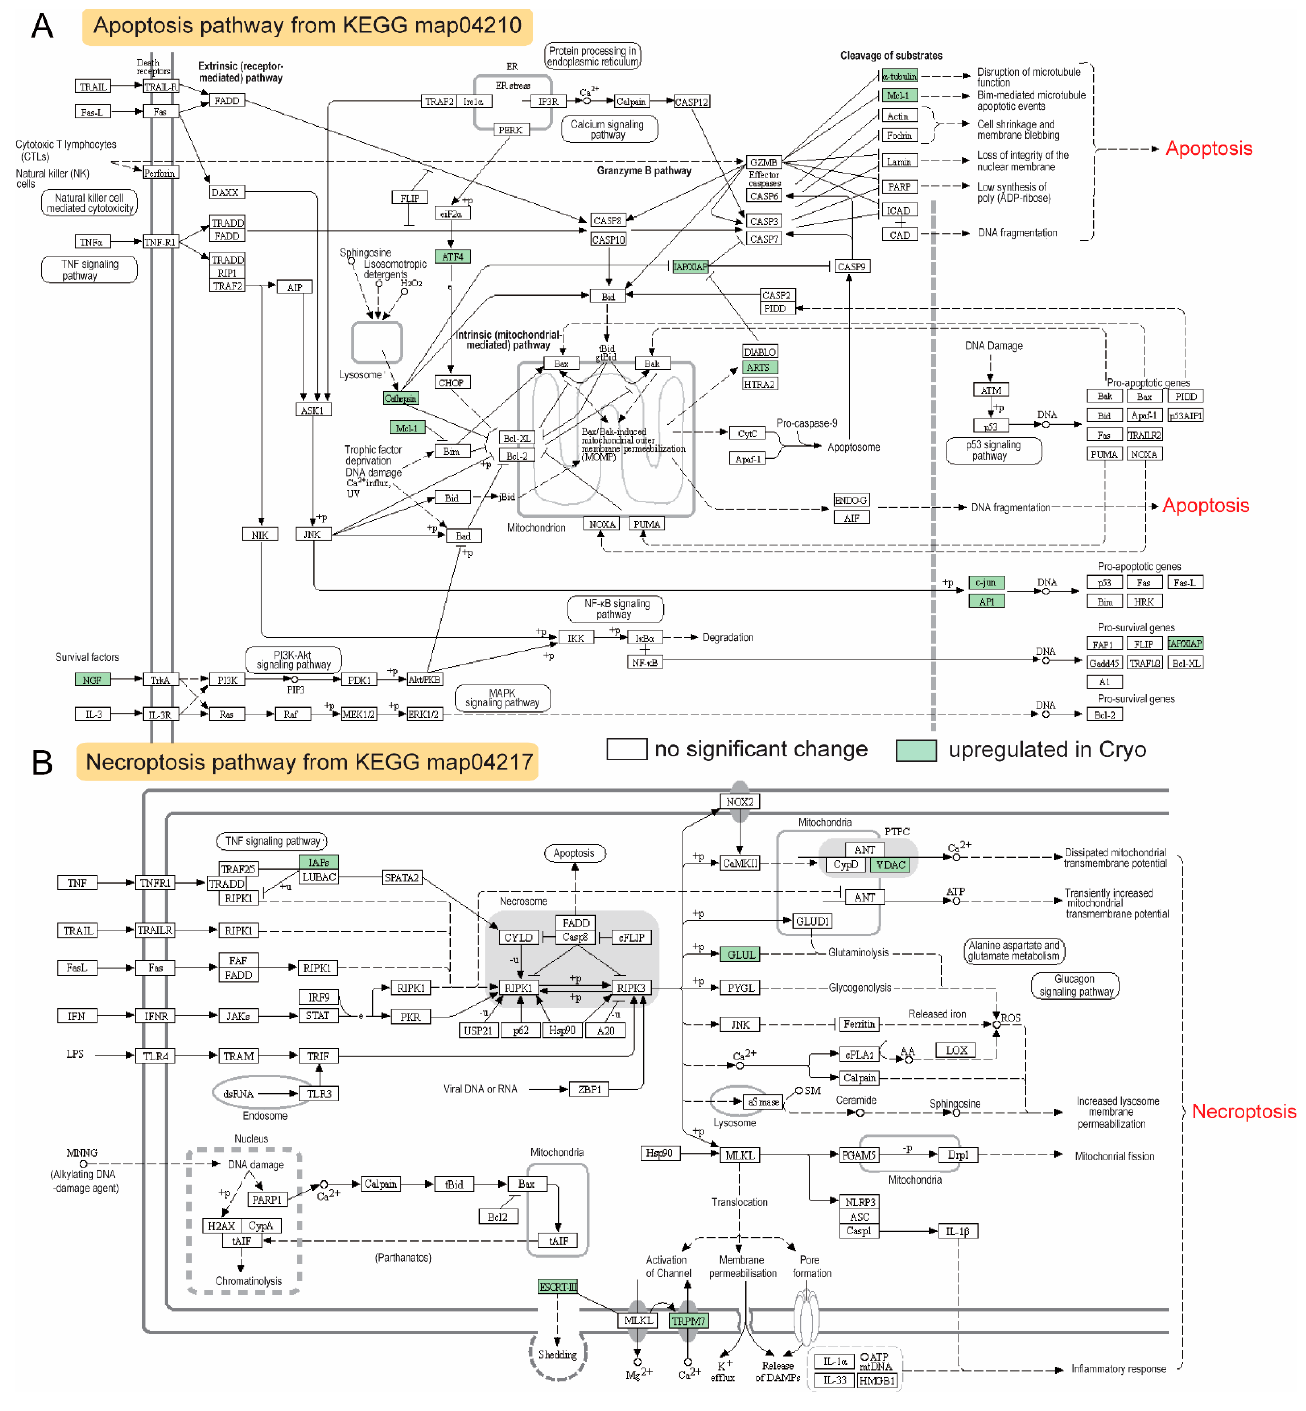
Figure 7. Effects of cryopreservation of sperm on the apoptosis and necrosis pathways in blue cat- fish, Ictalurus furcatus . ( A ) KEGG map of the apoptosis pathway (map04210). ( B ) KEGG map of necrosis (map04217). Upregulated genes, proteins, and enzymes were highlighted in green.